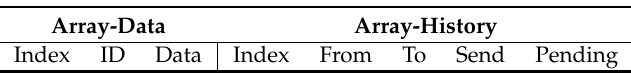
Table 1. Dynamic array for the Data and the